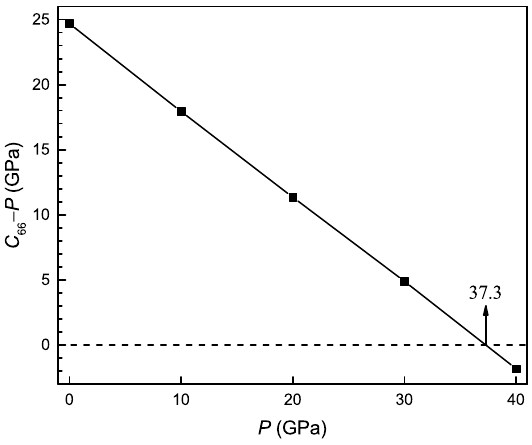
Figure 4. Difference between elastic constant C 66 and pressure P as a function of pressure for the Ti 4 Nb 3 Al 9